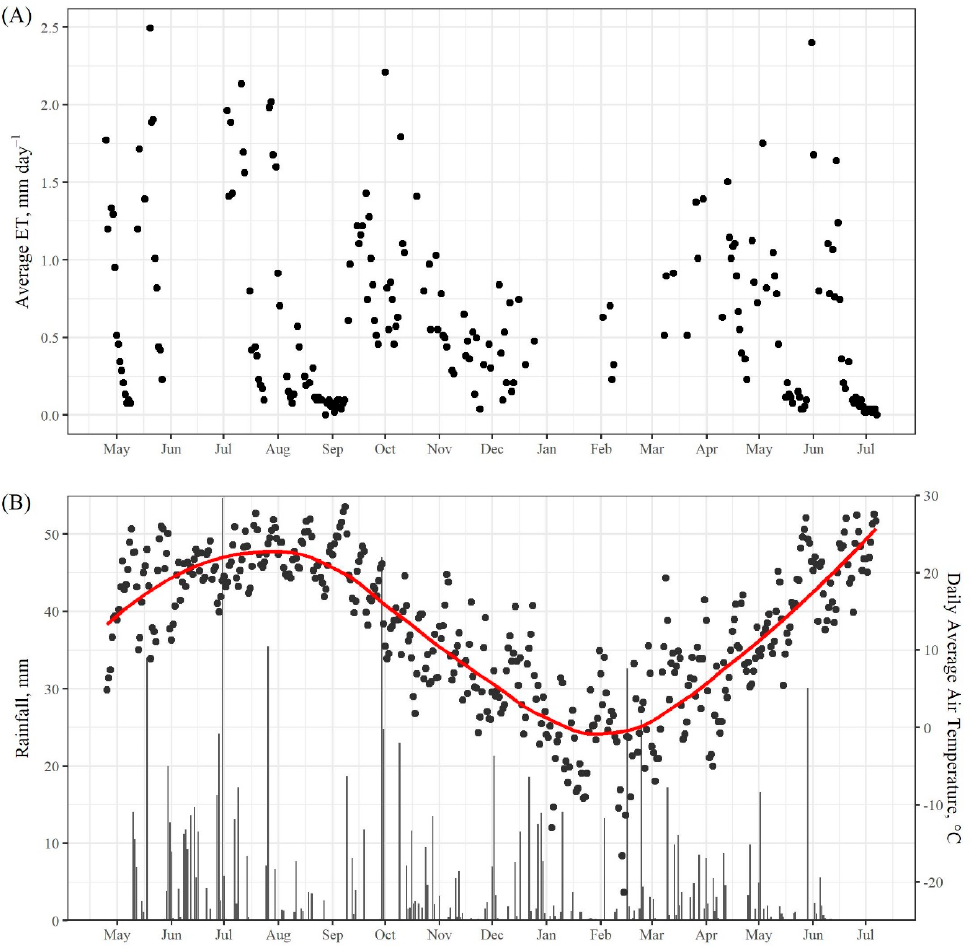
Figure 8. ( A ) Average evapotranspiration as quantified on the OnCenter green roof for dry days between 25 April 2015 and 8 July 2016. ( B ) Daily average temperature with a local linear regression and daily rainfall, as measured on the OnCenter green roof between 25 April 2015 and 8 July 2016.